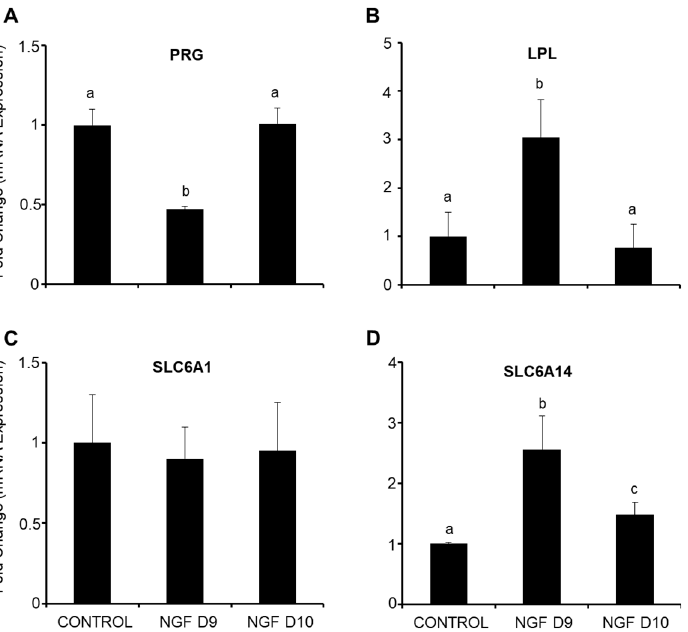
Figure 6. Relative mRNA transcript abundance of ( A ) progesterone receptor ( PGR ), ( B ) Lipoprotein Lipase ( LPL ), ( C ) Solute Carrier Family 6 Member 1 ( SLC6A1 ), and ( D ) Solute Carrier Family 6 Member 14 ( SLC6A14 ) in estrus-synchronized heifers and treated with PBS (control; n = 4), NGF D9 ( n = 4), or NGF D10 ( n = 4). Superscripts indicate significant differences ( p < 0.01) between control and treatment groups.